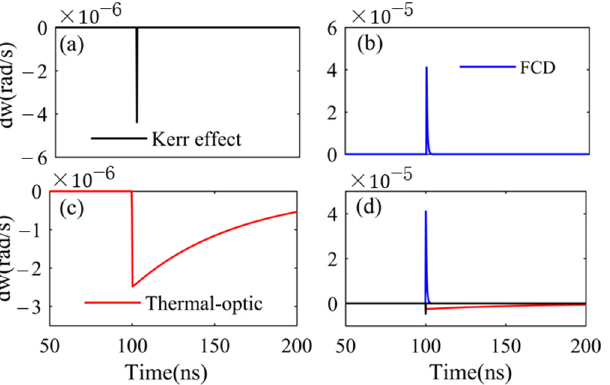
Figure 6. ( a – d ): The resonance frequency detuning caused by the Kerr effect, FCD and thermo-optic effect as a function of time.